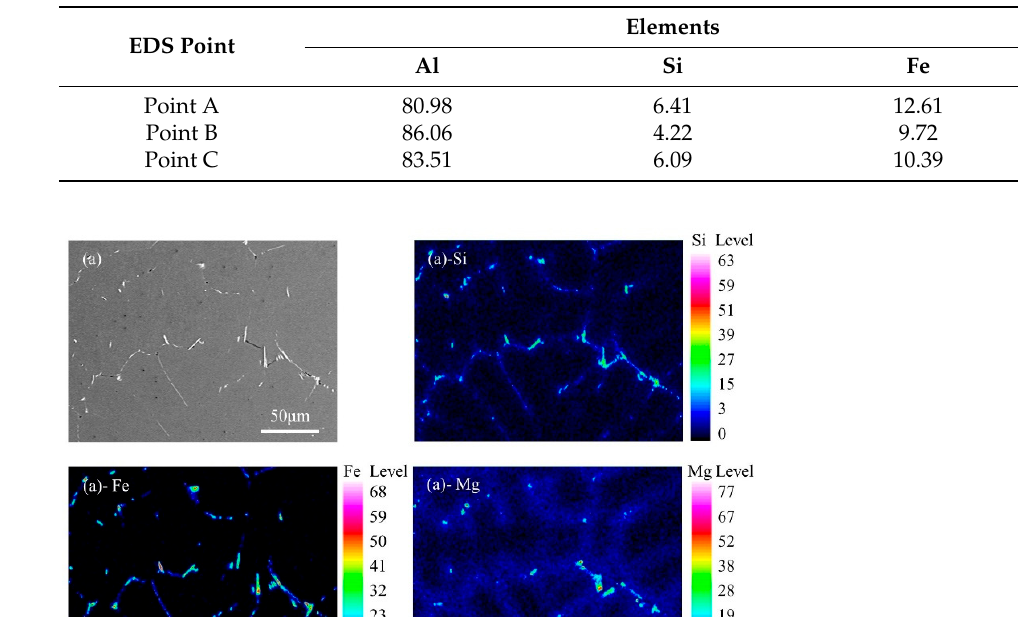
Figure 7. Electron backscattering image of homogenized specimen and energy spectrum dotting position of Table 4. Table 4. Energy spectrum analysis results of precipitated phase (atomic fraction/%).